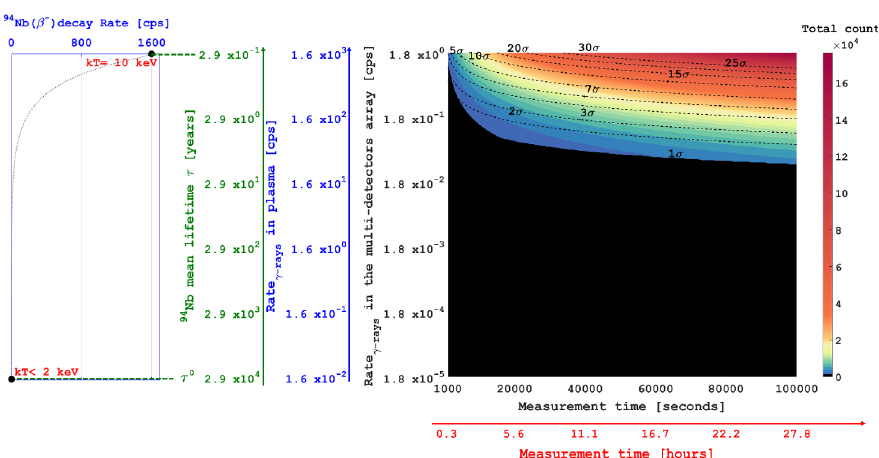
Fig.2 . Measurability plot for 94 Nb isotope. Y-axis reports the expected variation of the lifetime (green axis); the corresponding expected rate in cps, considering the amount of isotope in the PANDORA plasma volume (blue axis); the corresponding rate of detected gammas in the multi- detectors array (black axis). The X-axis reports the measurement time, while the colors are the total counts with corresponding sigma-levels shown as dotted lines. The left part of the figure shows the decay rate in cps vs